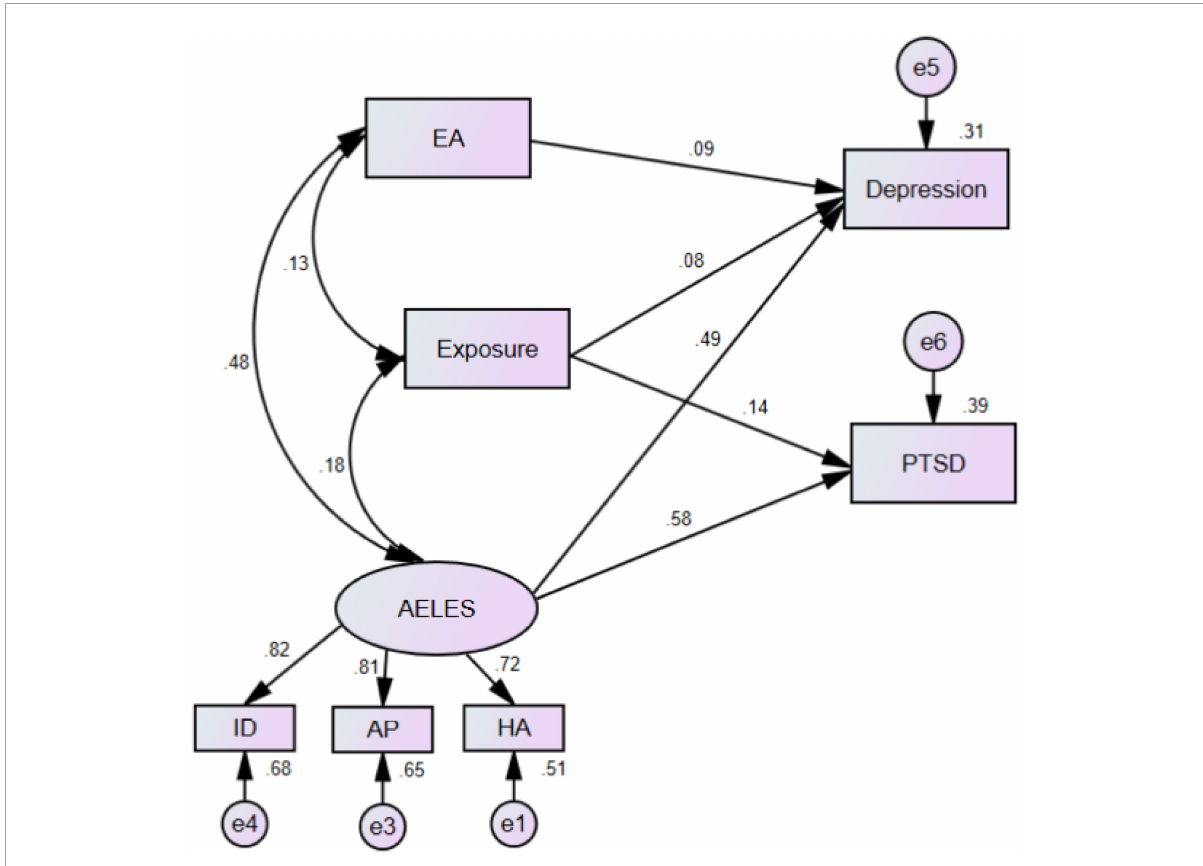
FIGURE1 Structural equation modeling model and standardized model path. PTSD, post-traumatic stress disorder; EA, emotional abuse; AELES, adolescent life events; ID, interpersonal difficulties; AP, academic pressure; HA, health and adaptability. “Exposure” refers to earthquake-related